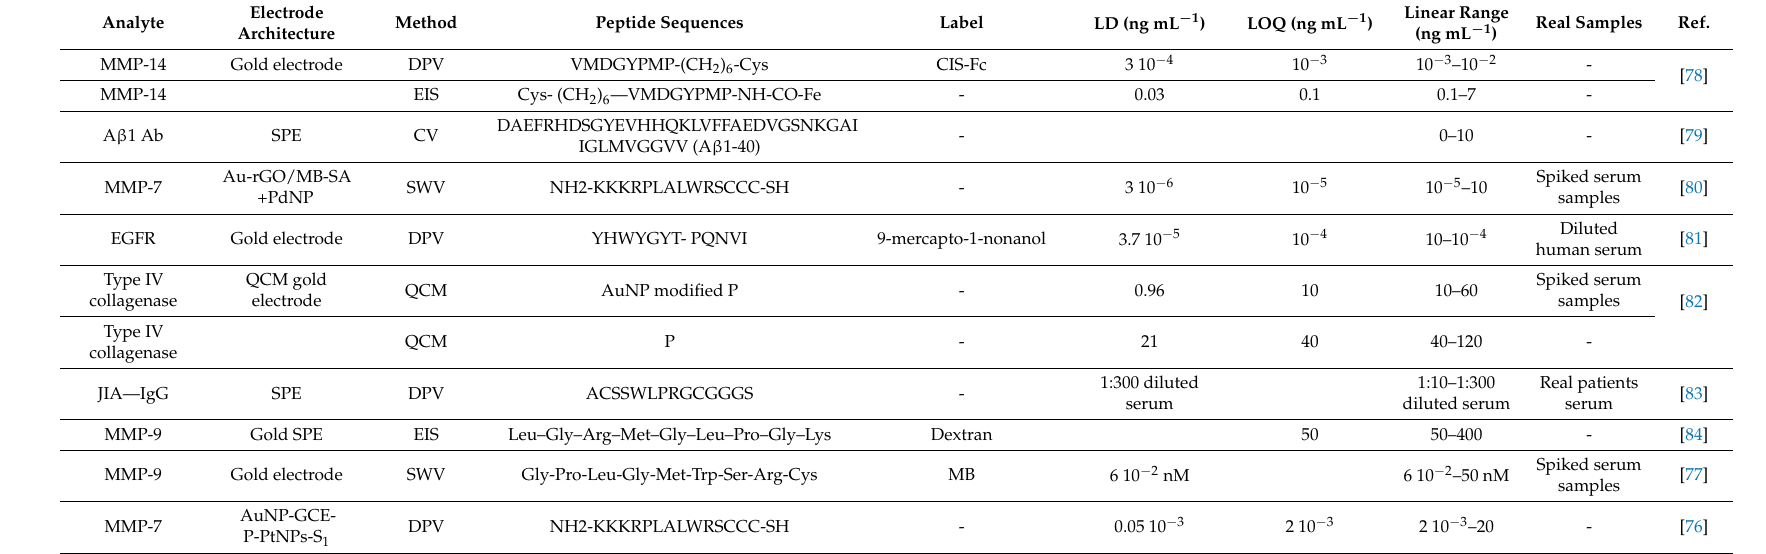
Table 2. Peptide based biosensors developed in recent